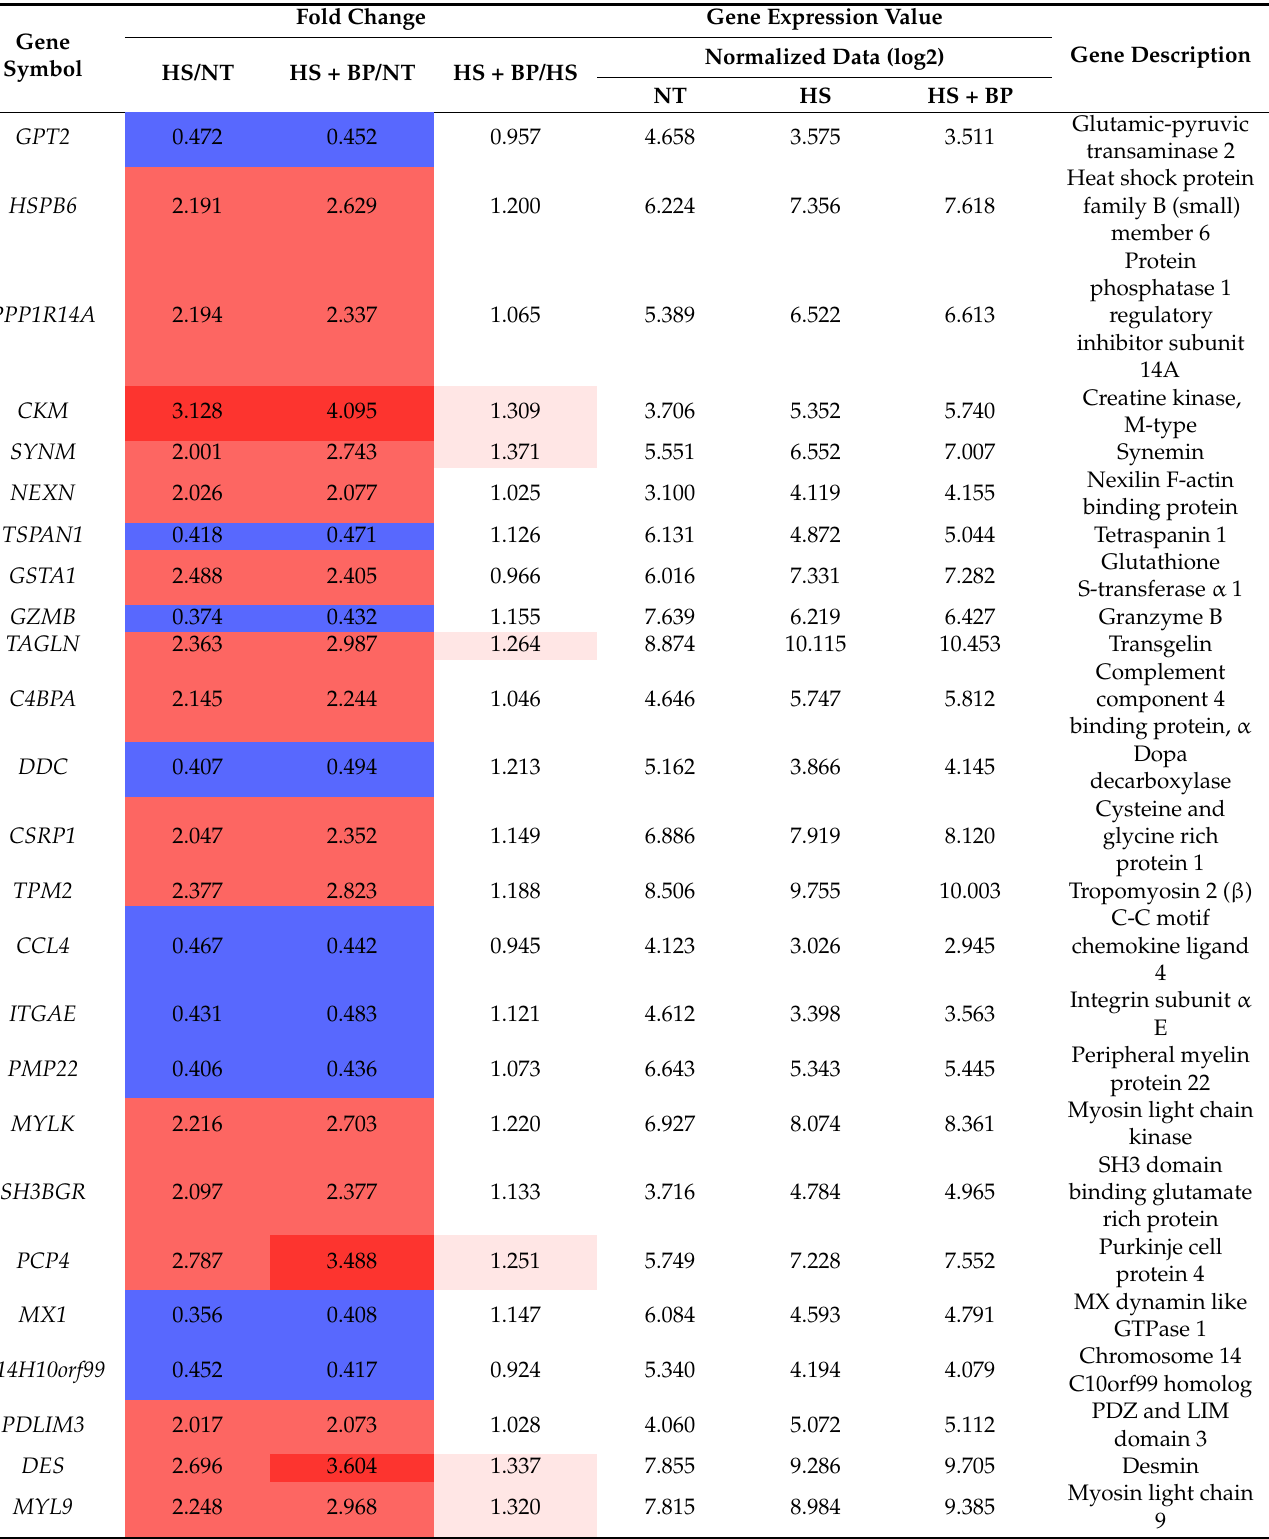
Table 1. Expression levels of differentially expressed genes in HS and BP groups. Red and blue background color in the fold change values means the increased and decreased gene expression, respectively, with the intensity of color indicating the magnitude of